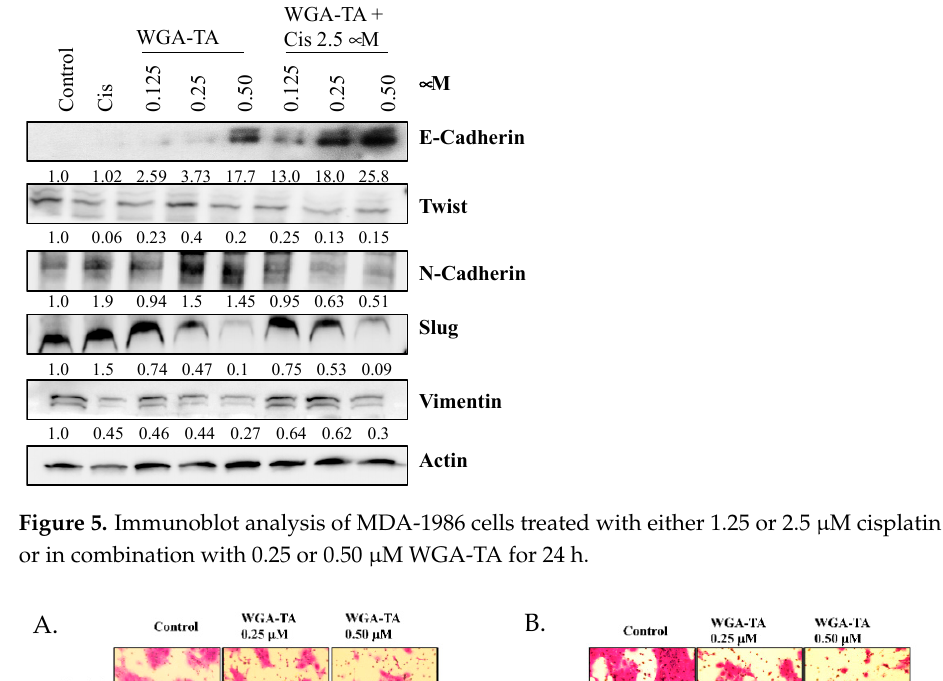
used as a loading control.